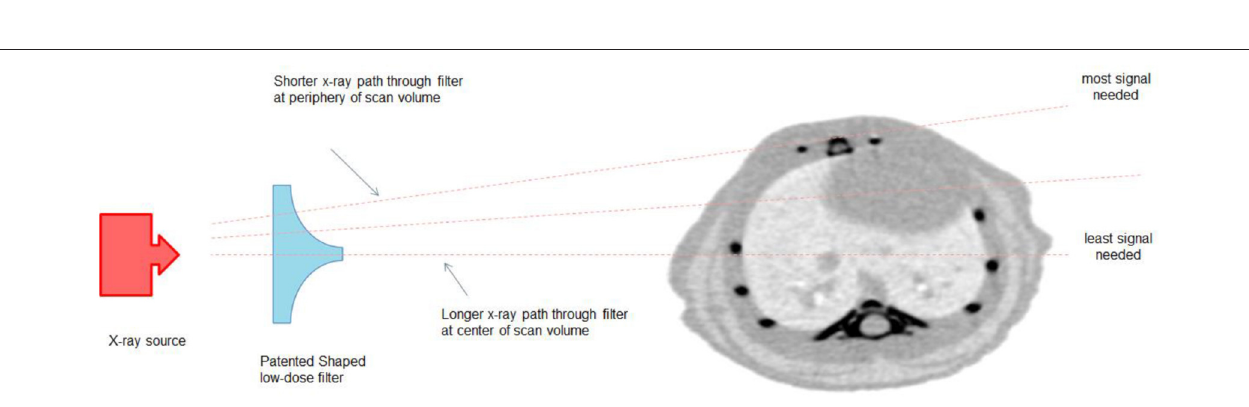
FIGURE 2 | High sensitivity total-body PET detector design. Mouse inside field of view.